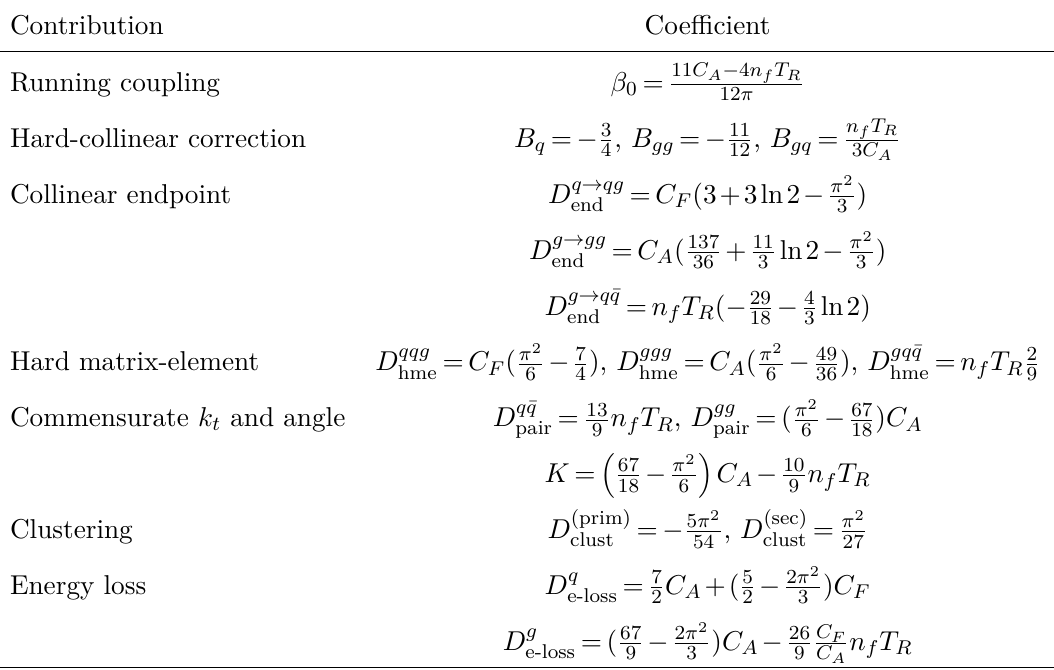
Table 2. Coefficients entering the NNDL h 3